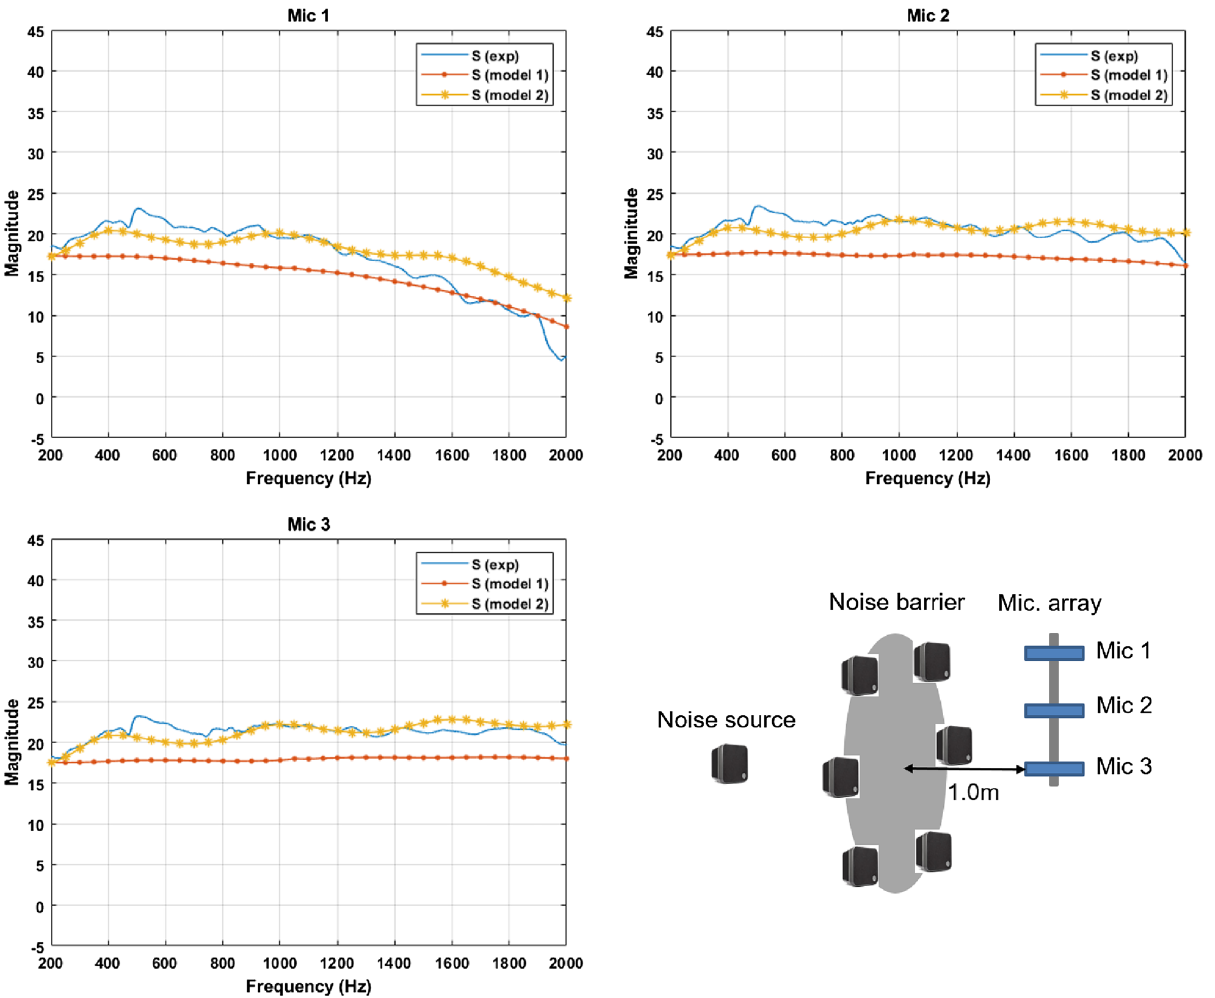
Figure 12. The secondary path at a distance of 1 m from the barrier: in the experiment (blue), model 1 (red), model 2